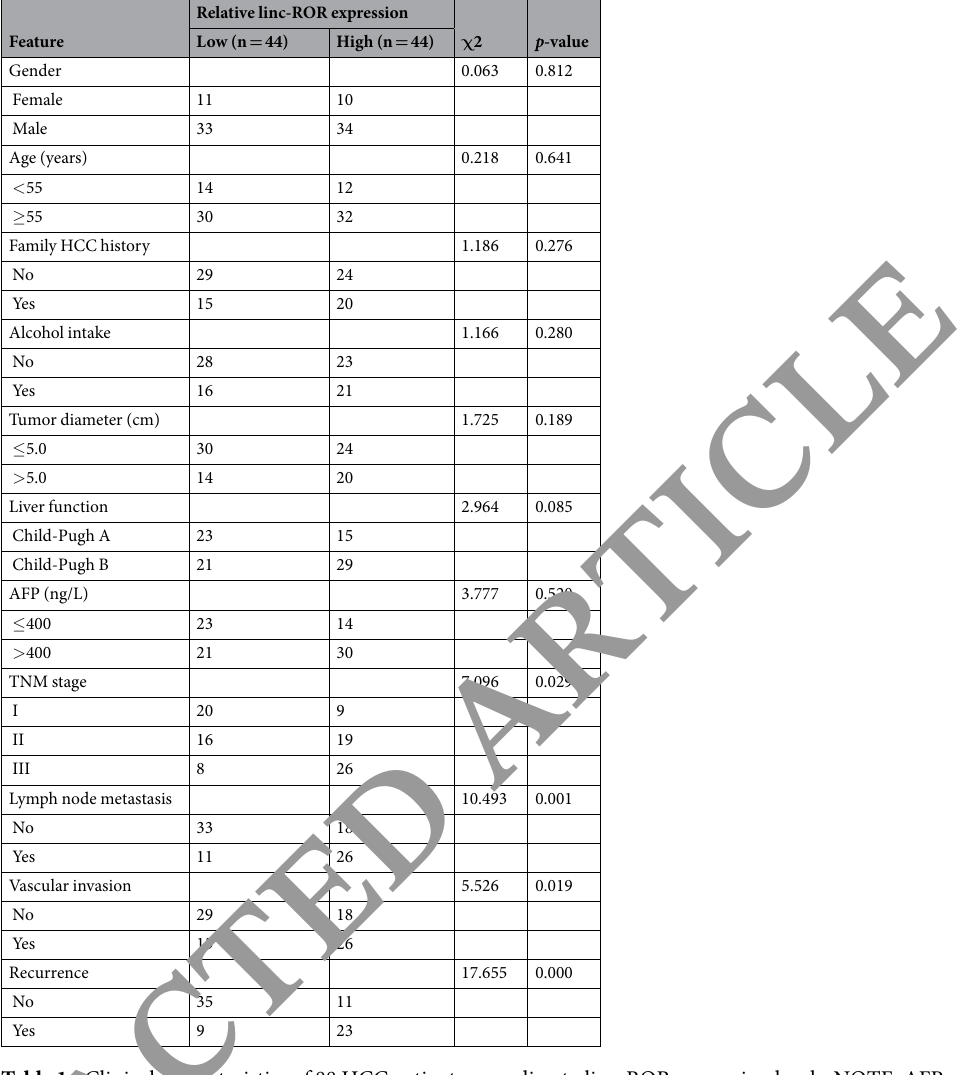
Table 1. Clinical characteristics of 88 HCC patients according to linc-ROR expression levels. NOTE: AFP, alpha-fetoprotein; TNM, tumor-node-metastasis. The median expression level was used as the cutoff. Low linc- ROR expression in 44 patients was classified as values below the 50th percentile. High linc-ROR expression in 44 patients was classified as values above the 50th percentile. Results were considered statistically significant at p <